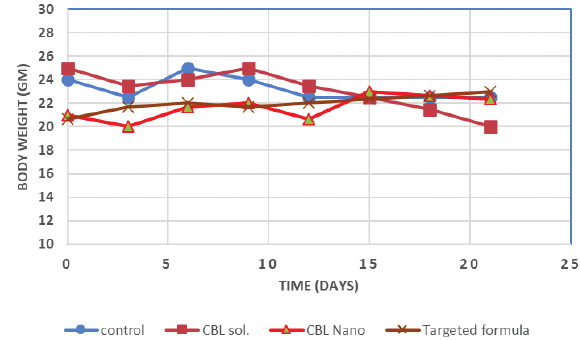
Figure 3 . Body weight changes of the tumor bearing mice over all the duration of the experiment (21 days) after i.v. injection of control (NS), CBL solution, CBL loaded non-targeted formula- tion, and CBL-bearing targeted formulation.